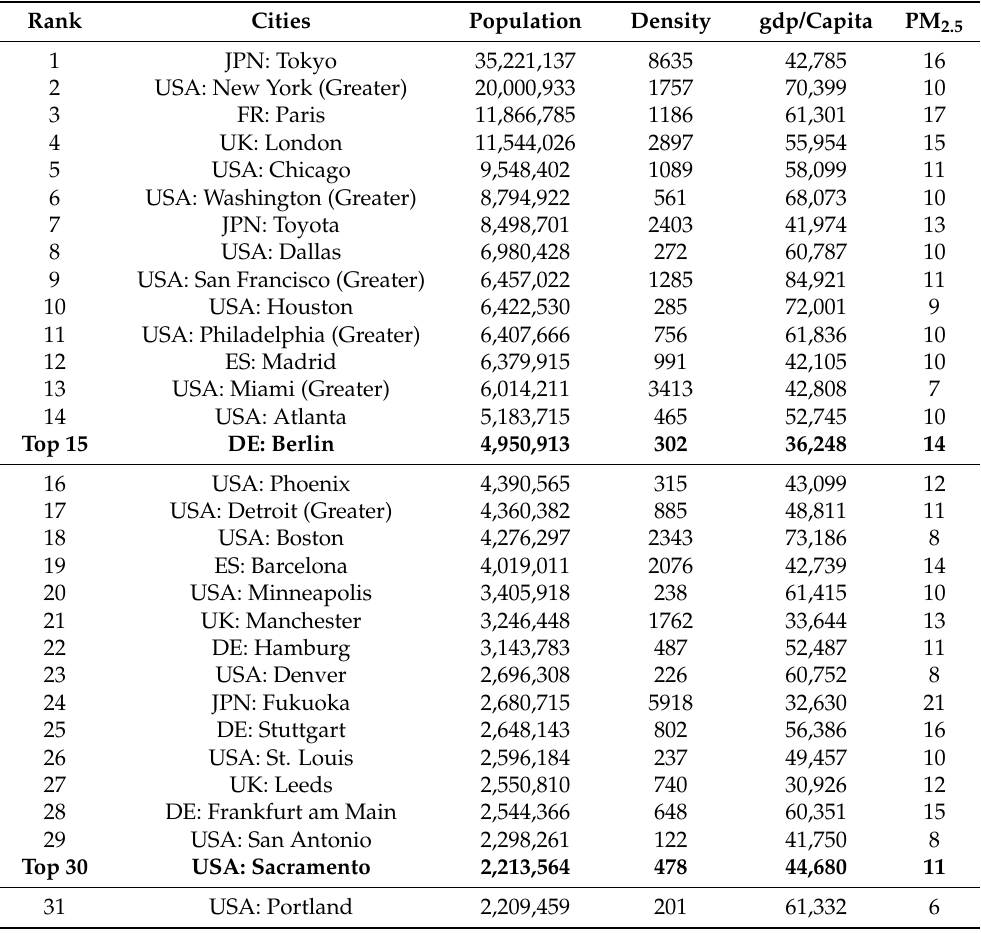
Table A3. Ranking of 254 cities into 5 subgroups by